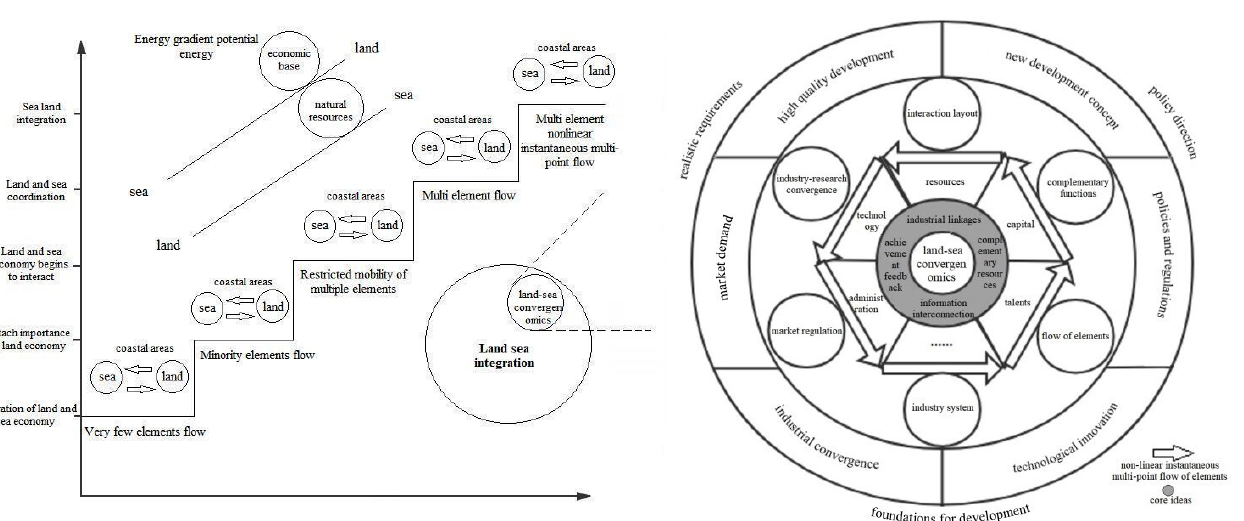
Table 1. System for assessing the development of a city’s capacity to integrate its marine and terres- trial ecological economies. Source: the data sources used in this study include the 2010–2020 editions of the China Marine Statistical Yearbook, China City Statistical Yearbook, Shandong Statistical Year- book, Liaoning Statistical Yearbook, Hebei Economic Yearbook, Tianjin Statistical Yearbook, Bulle- tin on Environmental Quality of China’s coastal waters, and the statistical bulletins of the relevant national departments.